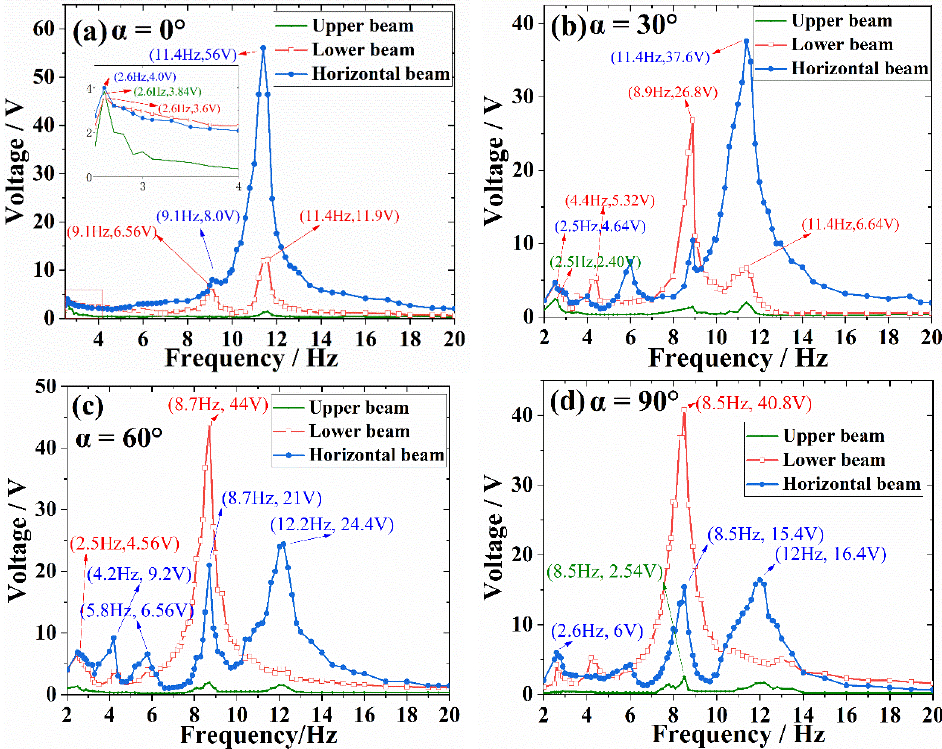
Figure 8. Open-circuit voltage versus frequency under vertical excitation with different α . To further investigate the effect of α , the output voltage of different beams at the three resonant peaks, namely 2.6 Hz, 9.1 Hz, and 11.4 Hz, are concluded in Figure 9. When α = 0 ◦ , the horizontal beam exhibits a maximum voltage of 56 V at the third resonant peak, corresponding to the mode result in FEA. As α increases, the excitation direction deviates further from the direction of third-order mode, causing a continuous decrease to the voltage at the third-order resonant frequency. For the voltages at first- and second-order modes, the voltage of lower beam increases at the beginning ( α = 0 ◦ ~60 ◦ ), and then maintains at a relative stable value at larger angles ( α > 60 ◦ ). This phenomenon may be attributed to the interdependence between the deformations of horizontal beam and upper and lower beams, whose vibration modes are the dominators at the first two resonant frequencies. For the upper beam, the largest voltage appears at the second frequency, whose bending mode is gradually triggered when α increases beyond 0 ◦ . The bending mode of upper beam cannot be activated by the vertical vibrations, and the small output voltages are mainly induced by the interdependence between different